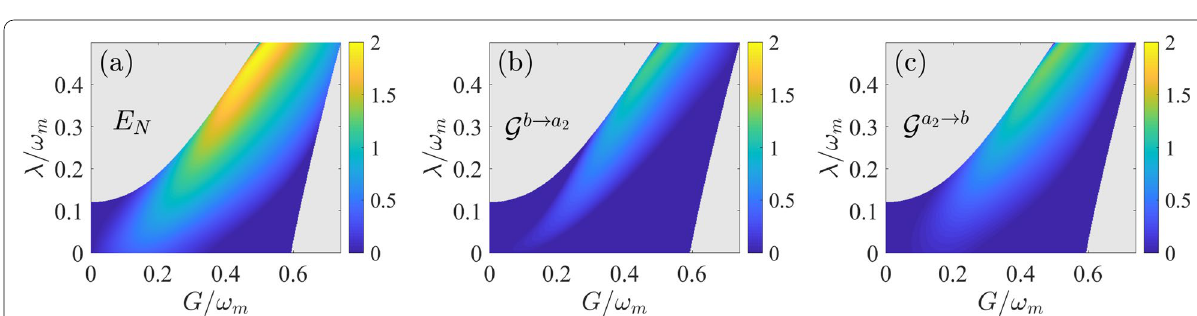
Fig. 4 a Steady‑state optomechanical entanglement E N , b Gaussian steering G b → a 2 , and c G a 2 → b versus the optomechanical coupling strength G 0.5 ω m . The other parameters are the same as Fig. and gain (cid:31) for J =